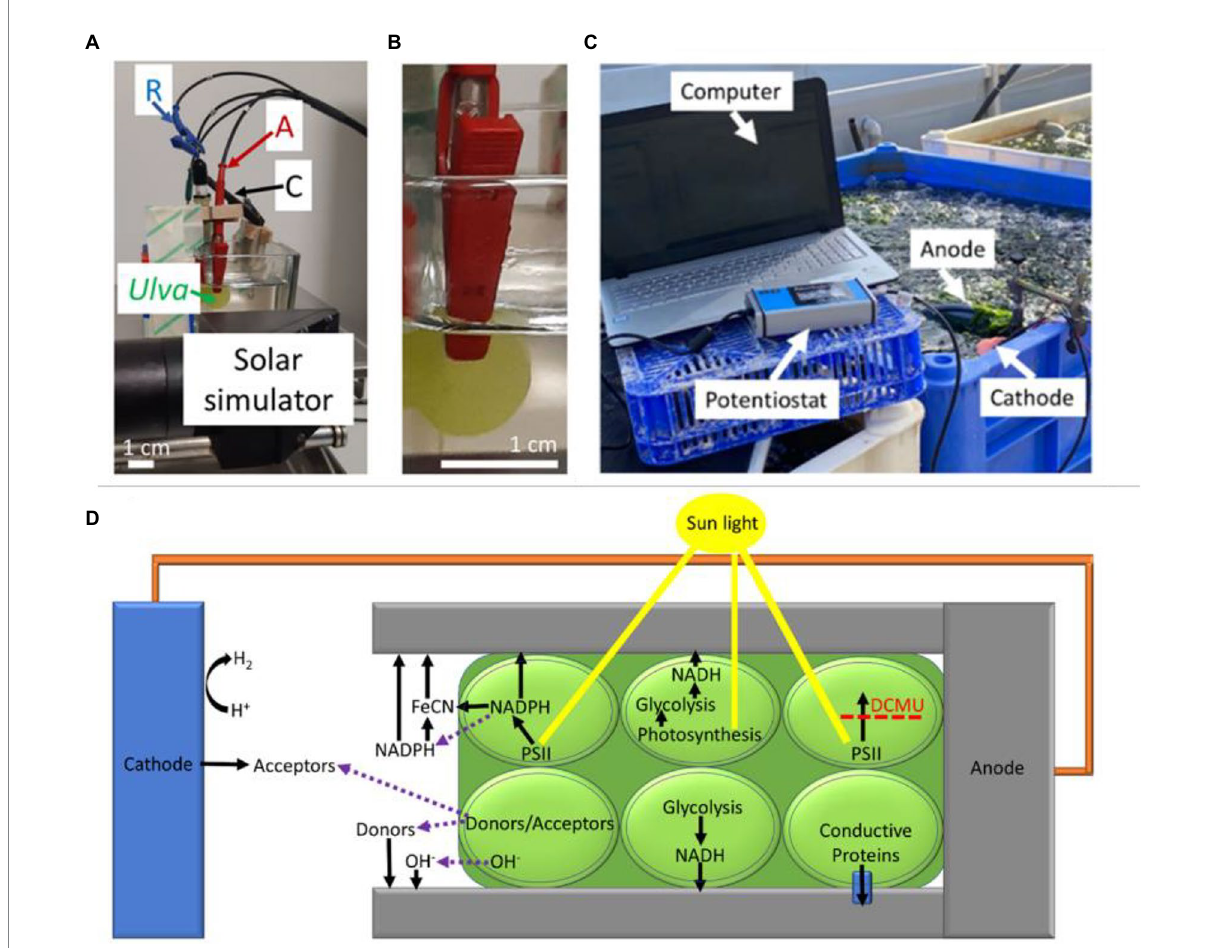
FIGURE 3 The analytical and large-scale BPECs used to obtain photocurrent from seaweeds. Reprinted with permission from Shlosberg et al. (2022a). (A) The analytical BPEC. A cutting of a seaweed such as Ulva in this picture, was electrically connected by a red clip with non-damaging flat surface serving as the anode (A). The cathode (C), and Reference electrodes (R) were placed in the solution of a synthetic seawater. A green arrow point at the section of Ulva . A solar simulator label shows the head of the solar simulator which illuminates the sample. (B) An enlargement of panel A which focuses on the connection between the anode and the Ulva . (C) A large scale BPEC. Bias-free current production of Ulva in its cultivation pool. The system is composed of an anode composed of a round aluminum plate and a cathode composed of a platinum wire which are dipped inside a cultivation pool with seawater and Ulva . The anode is held by a clamp and the cathode is placed in a sponge that is floating on the water surface. The pool is located on the seashore and contains a pipeline system that continuously streams water inside and outside of the pool. An average sunlight intensity of ~200 μ mol photons m-2 s-1 was measured at the pool surface. Pieces of Ulva are drifting in the water stream, hitting the anode, and producing electrical current. White arrows label the components of the system including the computer that operates the potentiostat, the potentiostat, the anode, and the cathode. (D) Possible electron transport mechanisms in seaweeds-BPEC. Based on our findings and together with previous models which were reported for BPECs based on microalgae, cyanobacteria, non-photosynthetic bacteria, and thylakoid membranes, we propose a model for various possible EET mechanisms for the macroalgae based BPEC. The Ulva thallus is marked in dark green, and its cells are marked with round light green shapes. The sunlight is marked in yellow. The anode clip is marked in gray and the Pt cathode is in a blue rectangular shape. A connective spring between the anode and cathode is marked in orange. The upper three cells of the Ulva describe EET mechanisms that are light-dependent. The lower three cells of the Ulva describe EET mechanisms that are light-independent. A small blue cone cylinder which is located in the lower right cell indicates a hypothetical membrane-bound conductive complex. Labels indicate the different materials. Black arrows indicate the direction of potential electron transport. The purple dashed arrows indicate molecular secretion from the inner part of the Ulva cells to the external medium. A dashed red line that crosses a black arrow indicates the inhibition of the electron transport by DCMU.